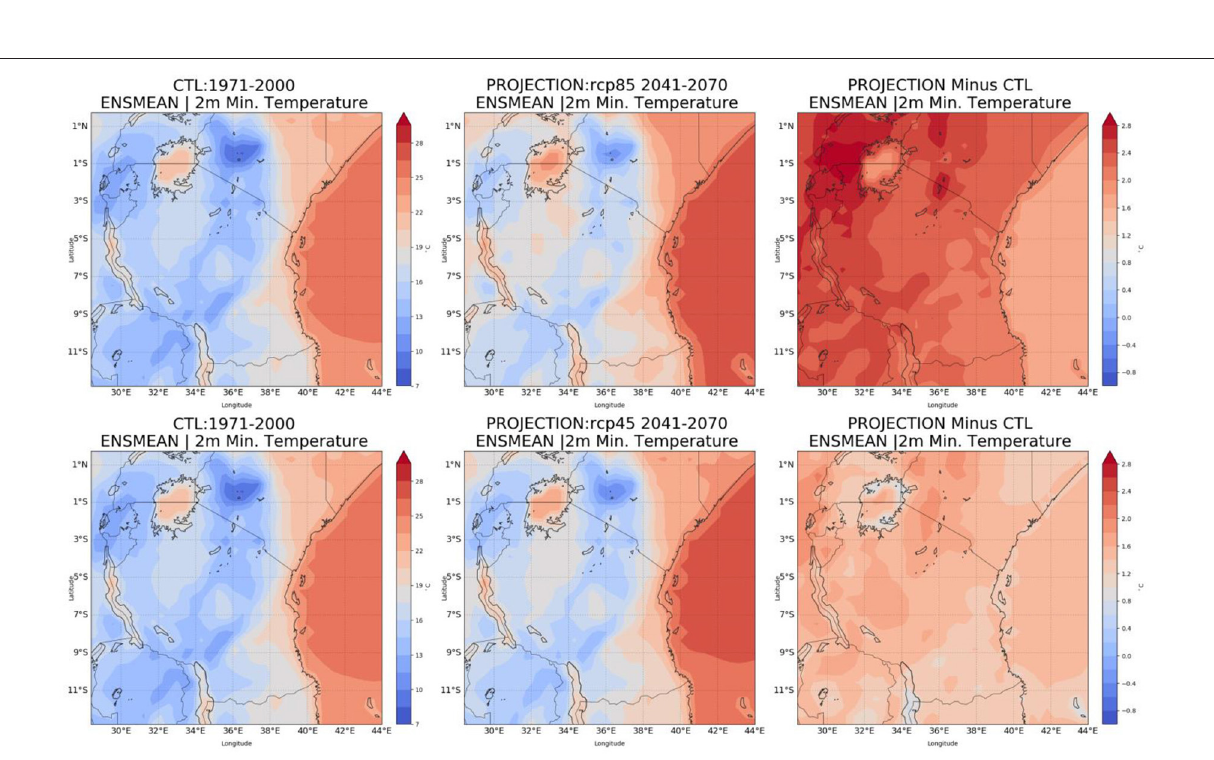
Frontiers in Environmental Science |